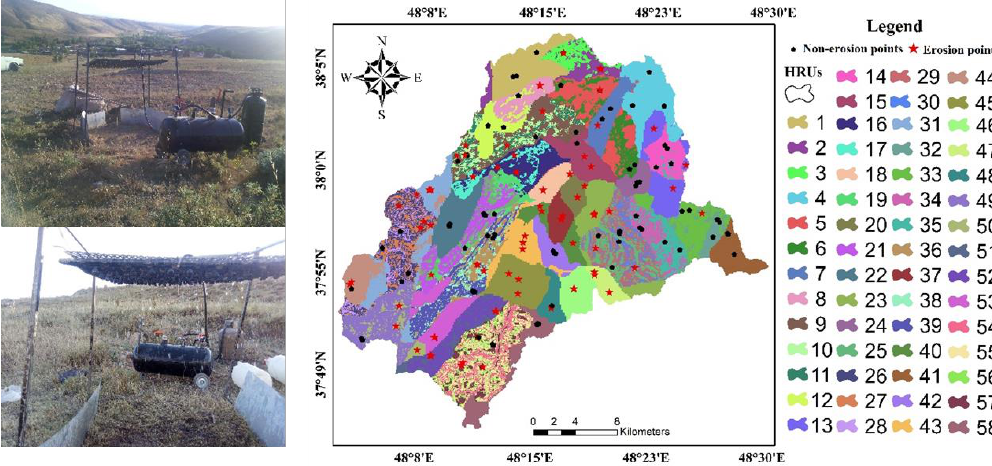
Figure 3. The rainfall simulator setup and its locations on different hydrological response units (HRUs). The different colors represent the raster map of the different HRUs.